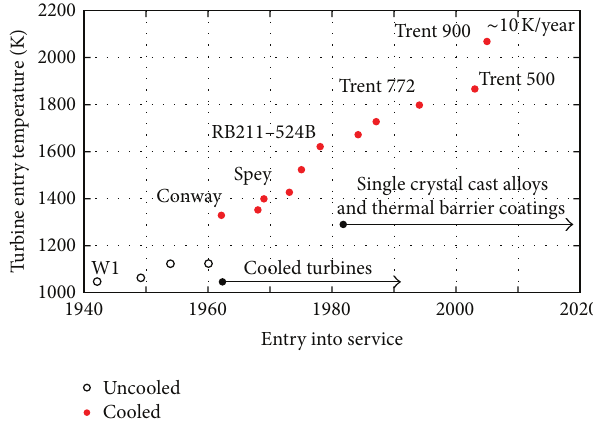
Figure 1: Turbine entry temperature versus date of entry into ser- vice. Adapted from Kyprianidis